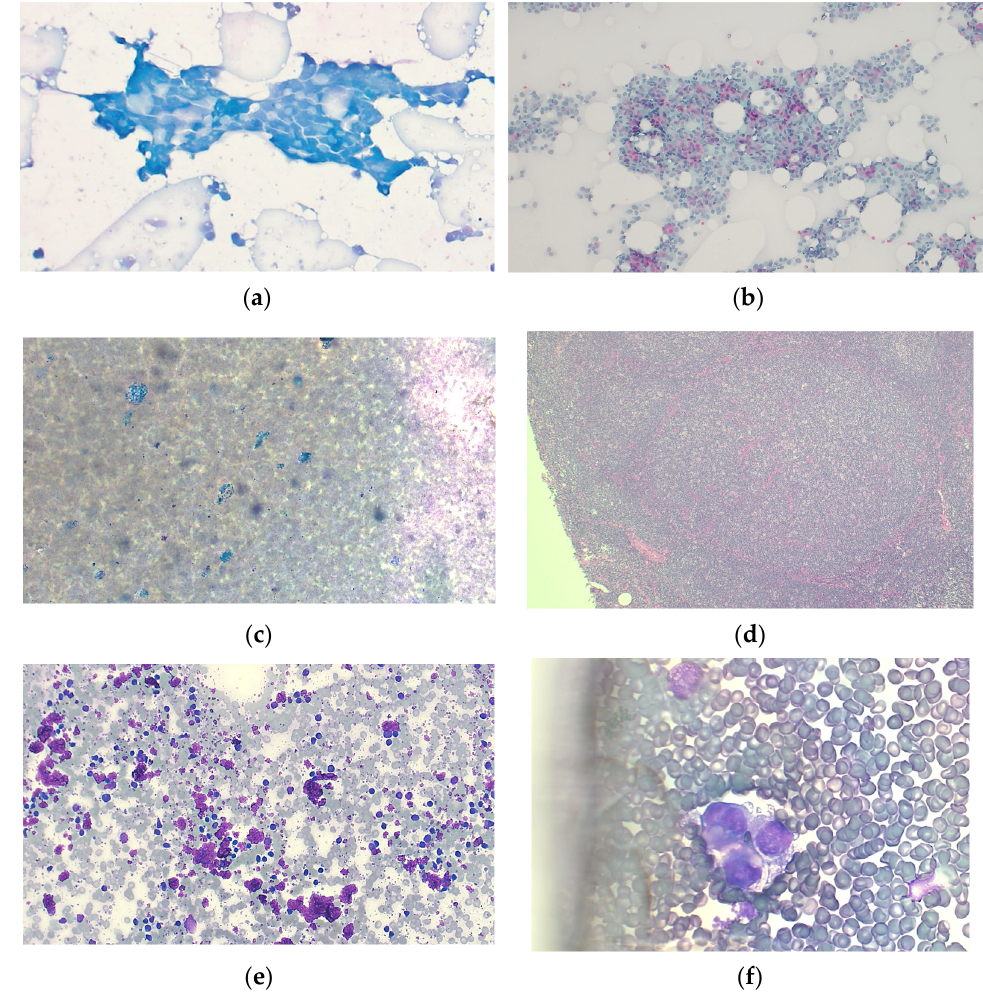
Figure 5. Examples of artefacts which may compromise cytological interpretation of the FNAB. ( a ) Formalin vapour results in blurring of the nuclei in an air-dried smear, allowing a diagnosis of suspicious only in this case. DQ ×200. ( b ) Slow drying effect (before placing the smear in alcohol) also compromises cytological diagnosis. DQ ×100. ( c ) Background haemorrhage and a thick smear shows haemosiderin-laden histiocytes only, prohibiting assessment. DQ ×40. This case corresponded to the ultrasound image 3 ( a ) and is a case of progressive transformation of germinal centres, as seen on the excision biopsy ( d ). H&E ×40. ( e ) Ultrasound gel, staining bright pink, obscures the lymphoid cells and also causes some slow drying effect due to a thin fluid film. DQ ×100. ( f ) The only atypical cells present in this smear were adjacent to the coverslip at the end of the slide, insufficient for a definite diagnosis of malignancy. The CNB showed metastatic lobular carcinoma. DQ ×400.